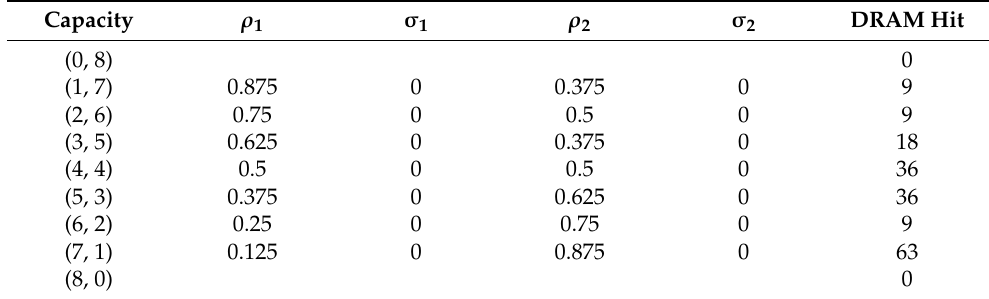
Table 1. DRAM layer hits under each capacity.